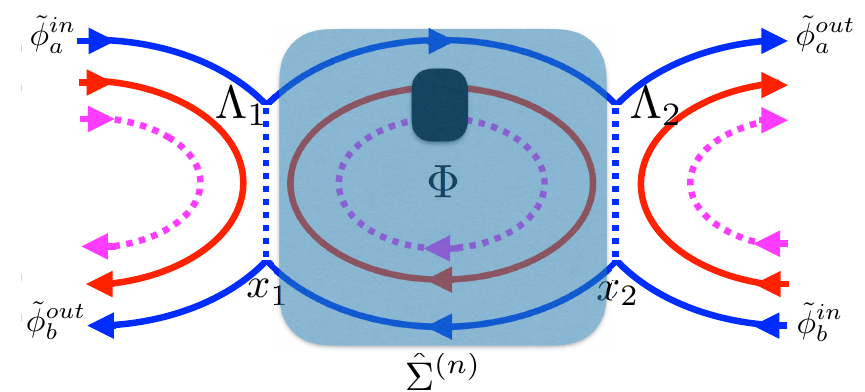
Figure 2: Schematic view of a FPI with n trapped channels in the interfering loop. The action of the interferometer in presence of interaction (assumed strong and short ranged in main text) can be described in terms of the edge-magnetoplasmon scattering matrix ˆ Σ ( n ) .